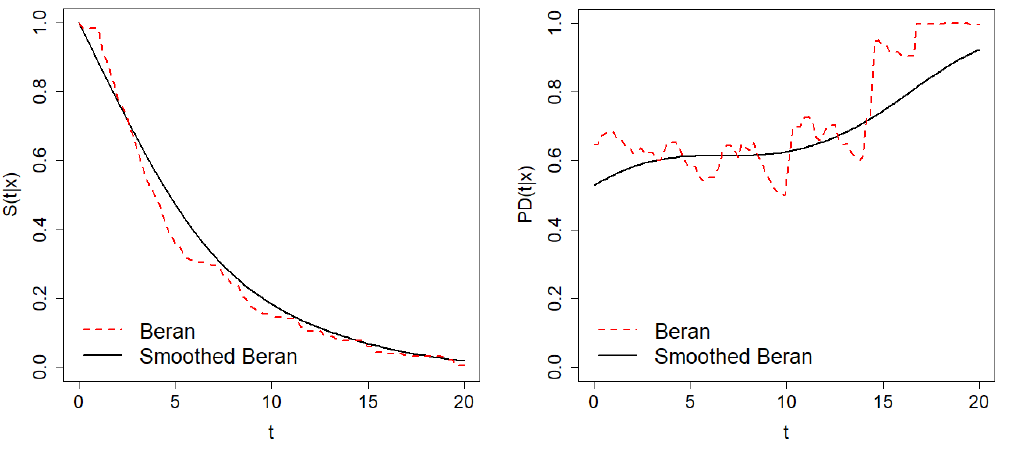
Figure 1. Estimation of S ( t | x ) ( left ) and PD ( t | x ) ( right ) at horizon b = 5 for x = 0.8 by means of Beran’s (dashed line) and smoothed Beran’s (solid line) estimators on the consumer credits